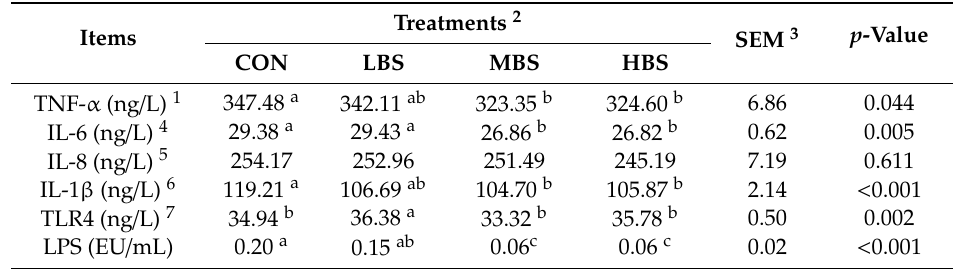
Table 2. E ff ect of dietary β -sitosterol (BBS) supplementation on cytokines, TLR4, and LPS in the blood of sheep.